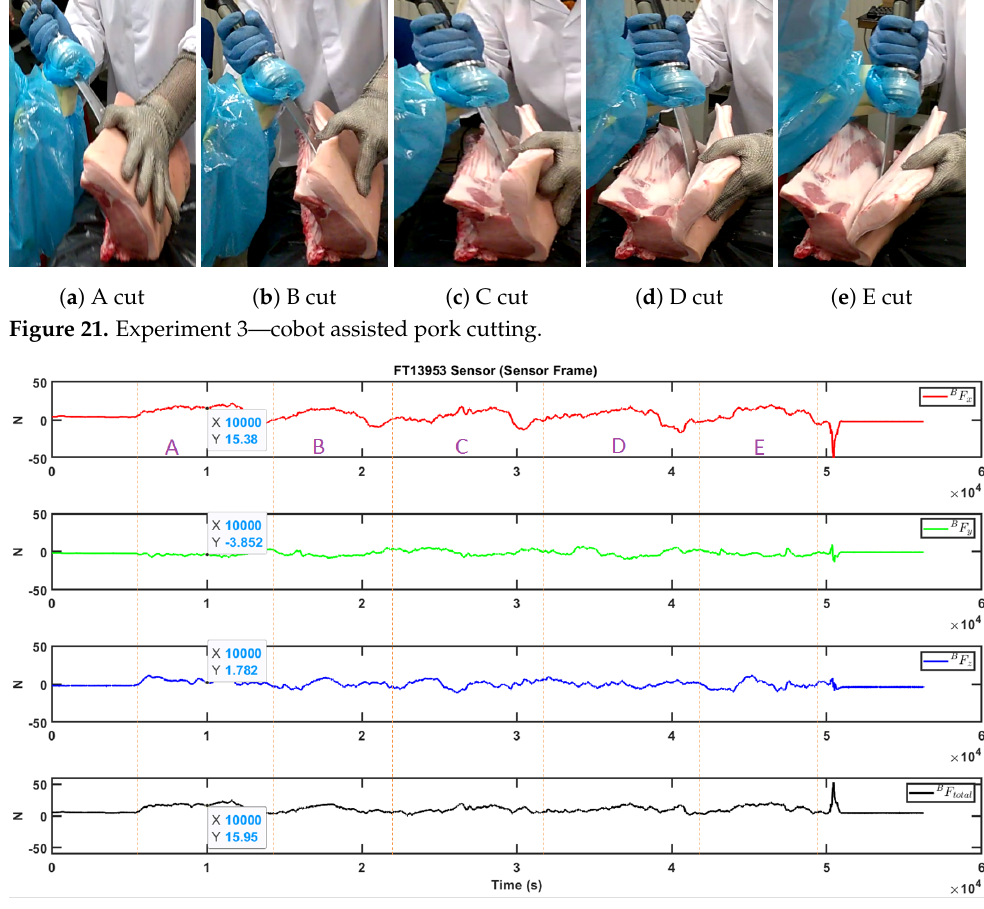
Figure 22. Forces applied by the user in Experiment